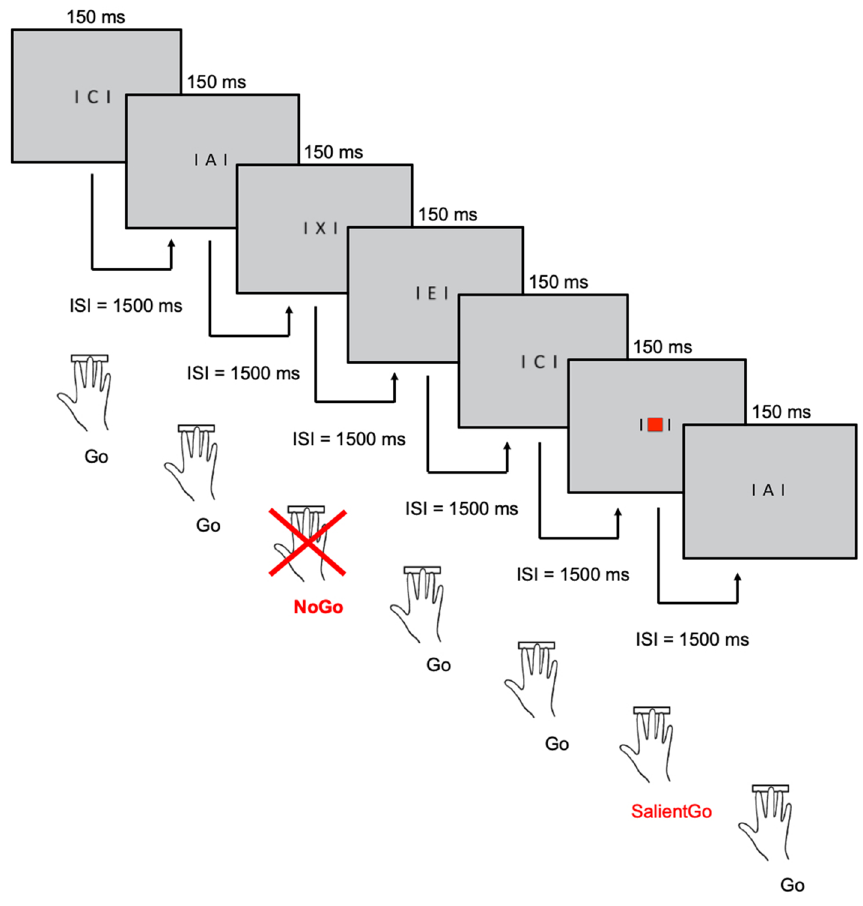
Figure 1. Schematic illustration of the Salience Continuous Performance Task (Salience CPT). Stimuli appeared on the screen for 150 ms followed by an inter-stimulus interval (ISI) of 1500 ms, summing up to a total trial duration of 1650 ms. Participants were instructed to press the space bar to all presented stimuli (i.e., letters and red squares) except the letter